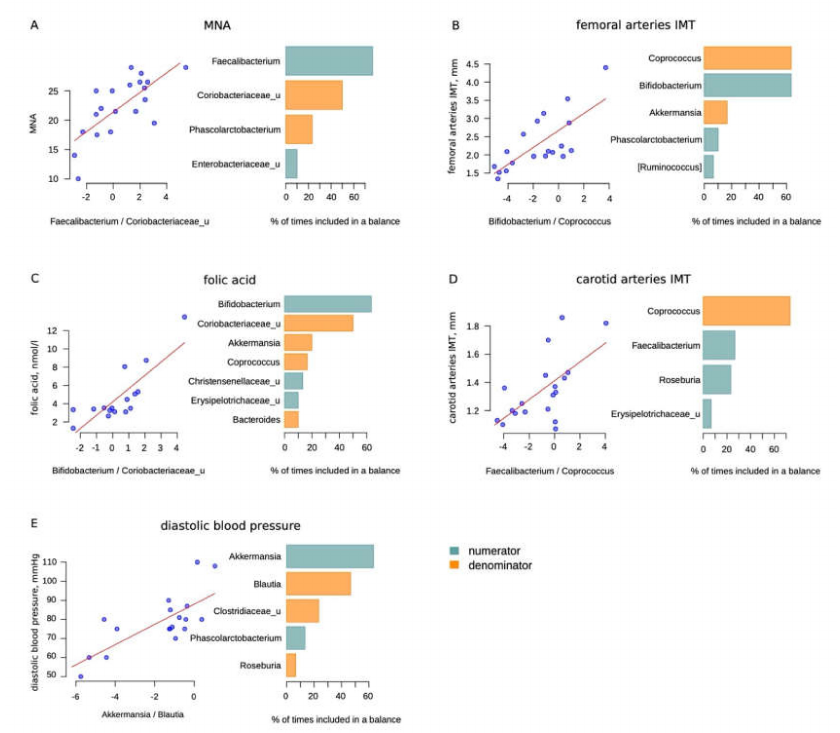
Figure 3. Selbal analysis results: ( A )—Mini Nutritional Assessment (MNA) scale; ( B )—femoral arteries intima media thickness (IMT), mm; ( C )—folic acid, nmol / L; ( D )—carotid arteries IMT (not significant), mm; ( E )—diastolic blood pressure, mmHg (less than 50% of cases for balance according to the results of cross-validation for Blautia). The scatter plots on the left illustrate the regression between the balances determined on the whole dataset and the analyzed factor. The barplots on the right illustrate the stability of the three most frequent balanced members during the cross-validation procedure: the blue bars correspond to the numerator members and orange—to the denominator